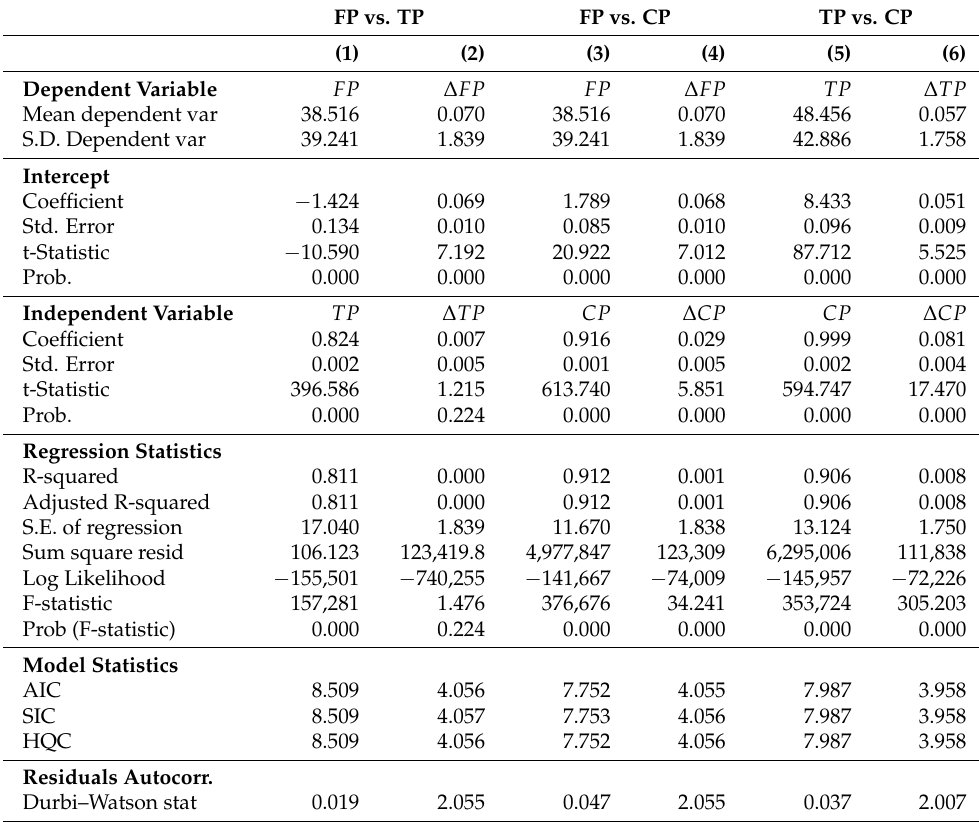
Table 3. Overall panel